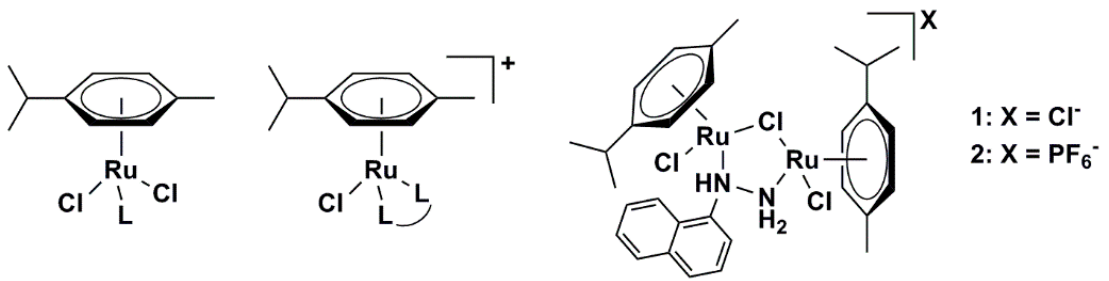
Figure 1. General structure of “half sandwich” Ru(II)-arene compounds and structures of the obtained complexes 1 and 2 ( right ).